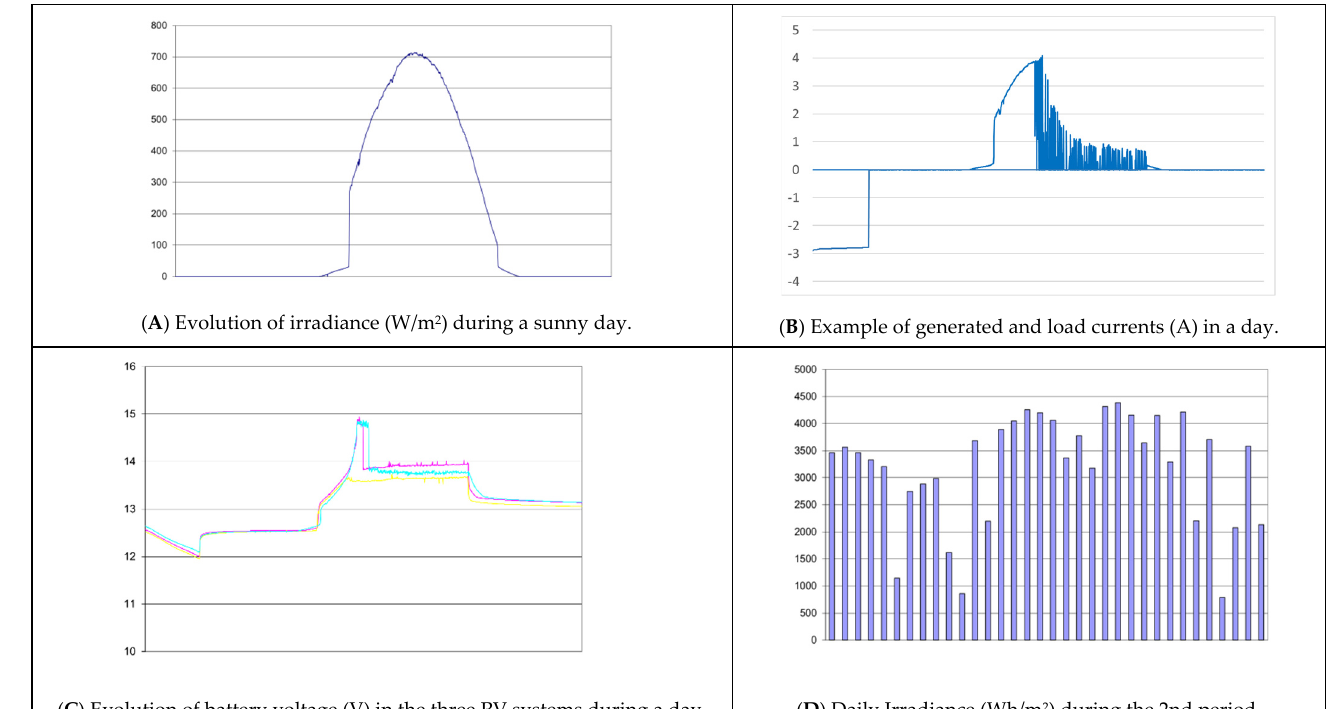
Figure 8. Example of data obtained in the first experiment with Group A batteries.